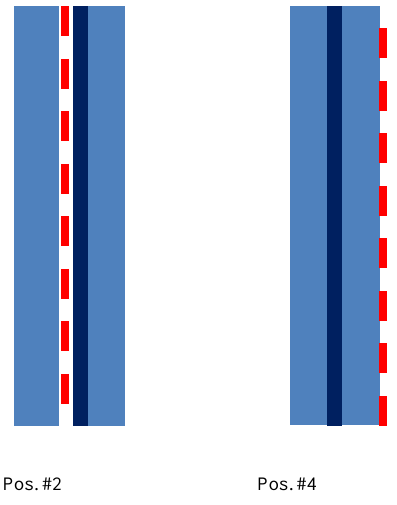
Pos. Fig. 3. Schematic position of coating position in measured laminates (glass light blue, solar PVB dark blue, coating red dotted line)